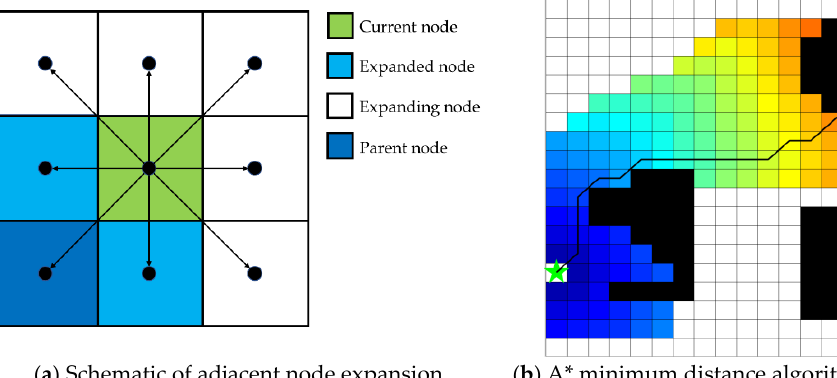
Figure 10. A* path planning algorithm schematic diagram. ( a ) Schematic of adjacent node expansion; ( b ) The shortest path of A* algorithm. The green star represents the starting point, and the yellow diamond represents the goal point. The shortest path is the black line between the starting point and the end point. The color grids are expanded nodes. The deeper the blue is, the closer the starting point is, and the deeper the red is, the closer the end point is. A set of white grids represents a feasible space, and black grids are obstacles.